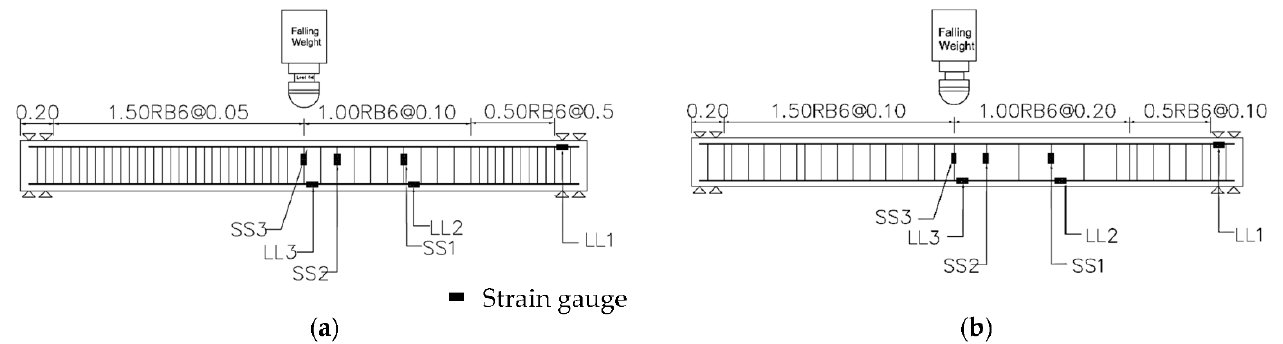
Figure 1. Dimensions and strain gauge locations (unit: m): ( a ) 100 mm stirrup spacing; ( b ) 200 mm stirrup spacing.